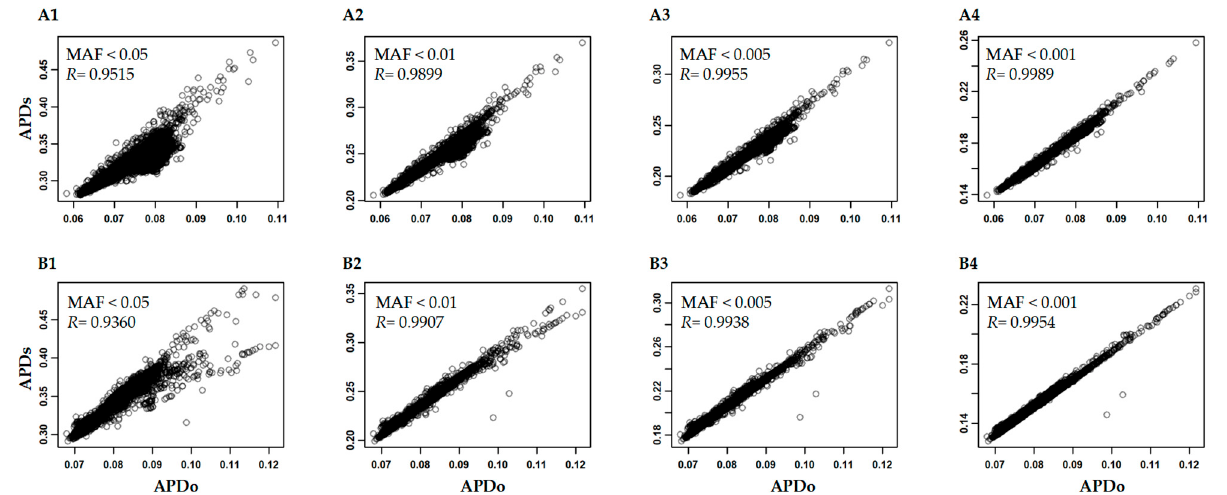
Figure 4. The correlations of APD estimates in the Hordeum vulgare ( A ) and Cicer arietinum-f300k ( B ) data sets for all the original SNPs (APDo) and subject to removal of SNPs with minor allelic frequencies (MAF) from 0.001 to 0.05 (APDs).